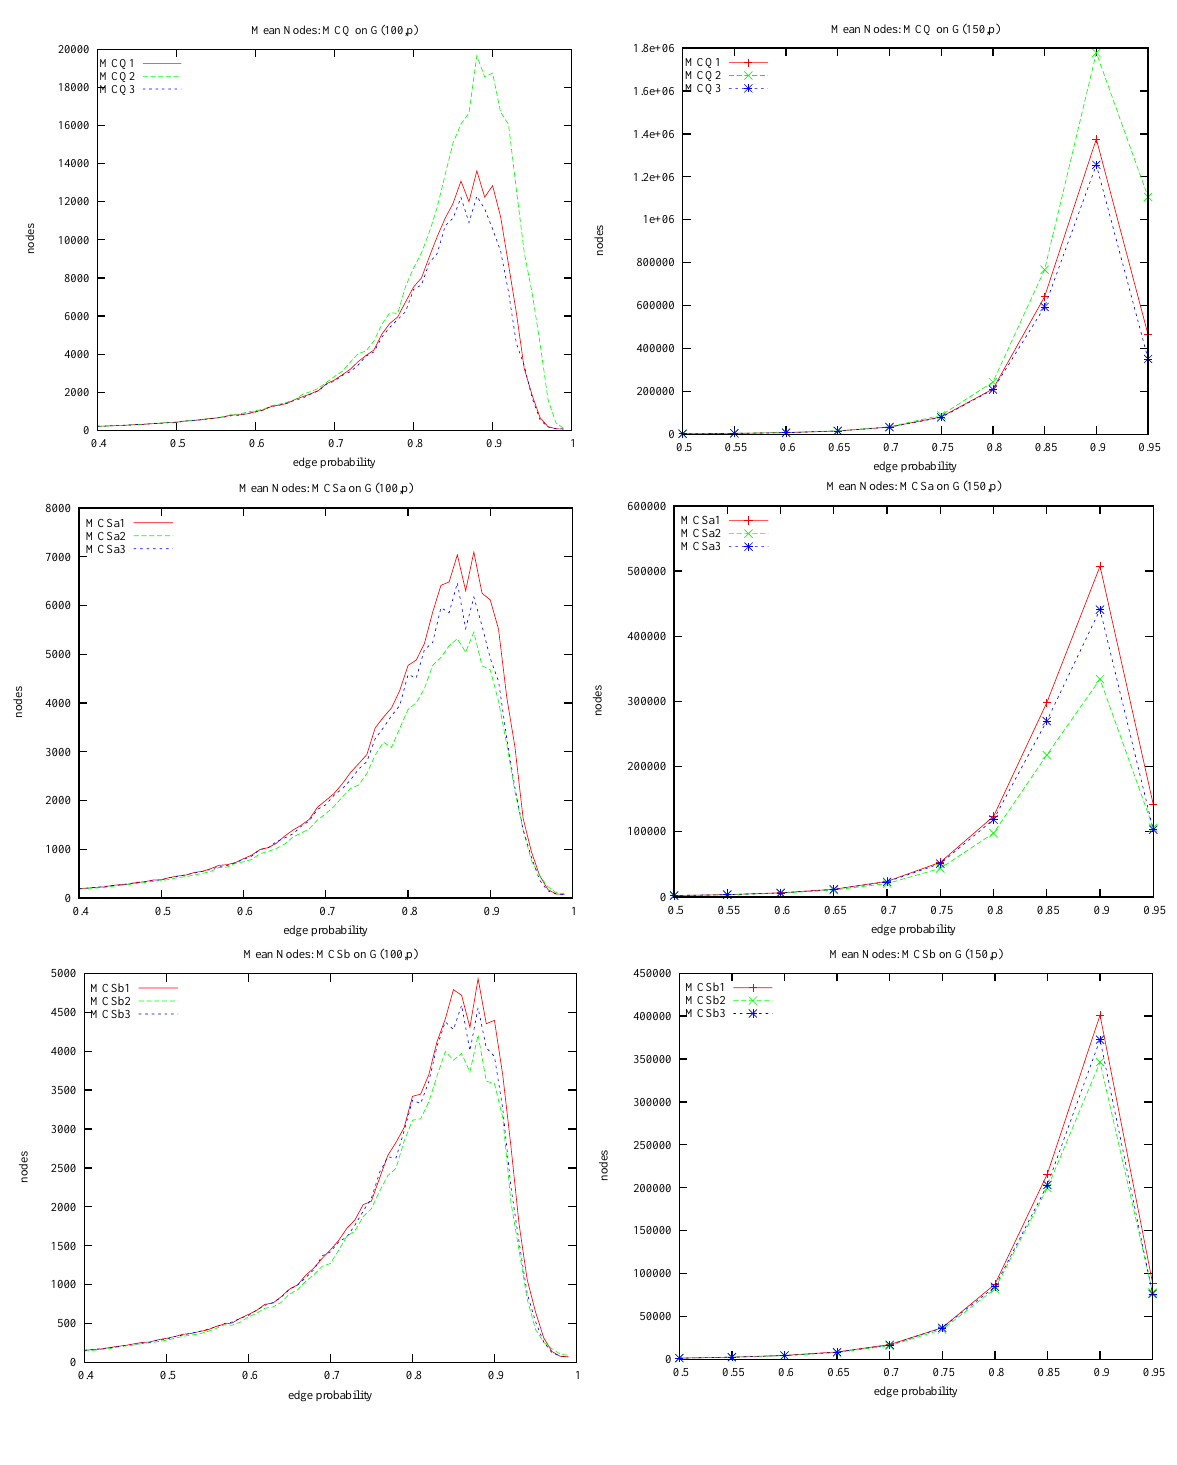
Figure 8. The effect of style on MCQ, MCSa and MCSb. On the left G (100 , p ) and on the right G (150 , p ) . Plotted is search effort in nodes against edge probability. The top two plots are for MCQ, middle plots MCSa and bottom